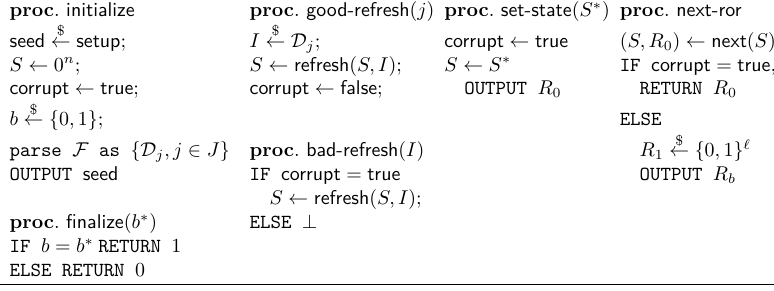
Figure 15: Procedures in Security Game ROB ( F )